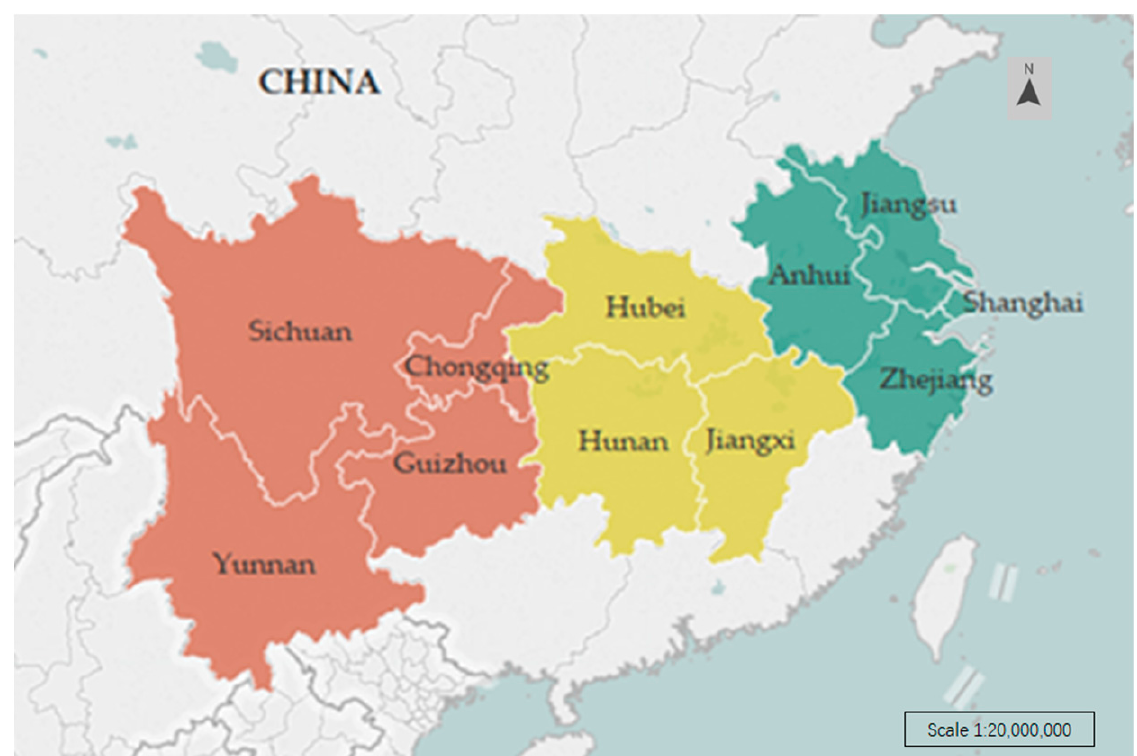
Figure 1. Geographical distribution map of the Yangtze River Economic Belt.